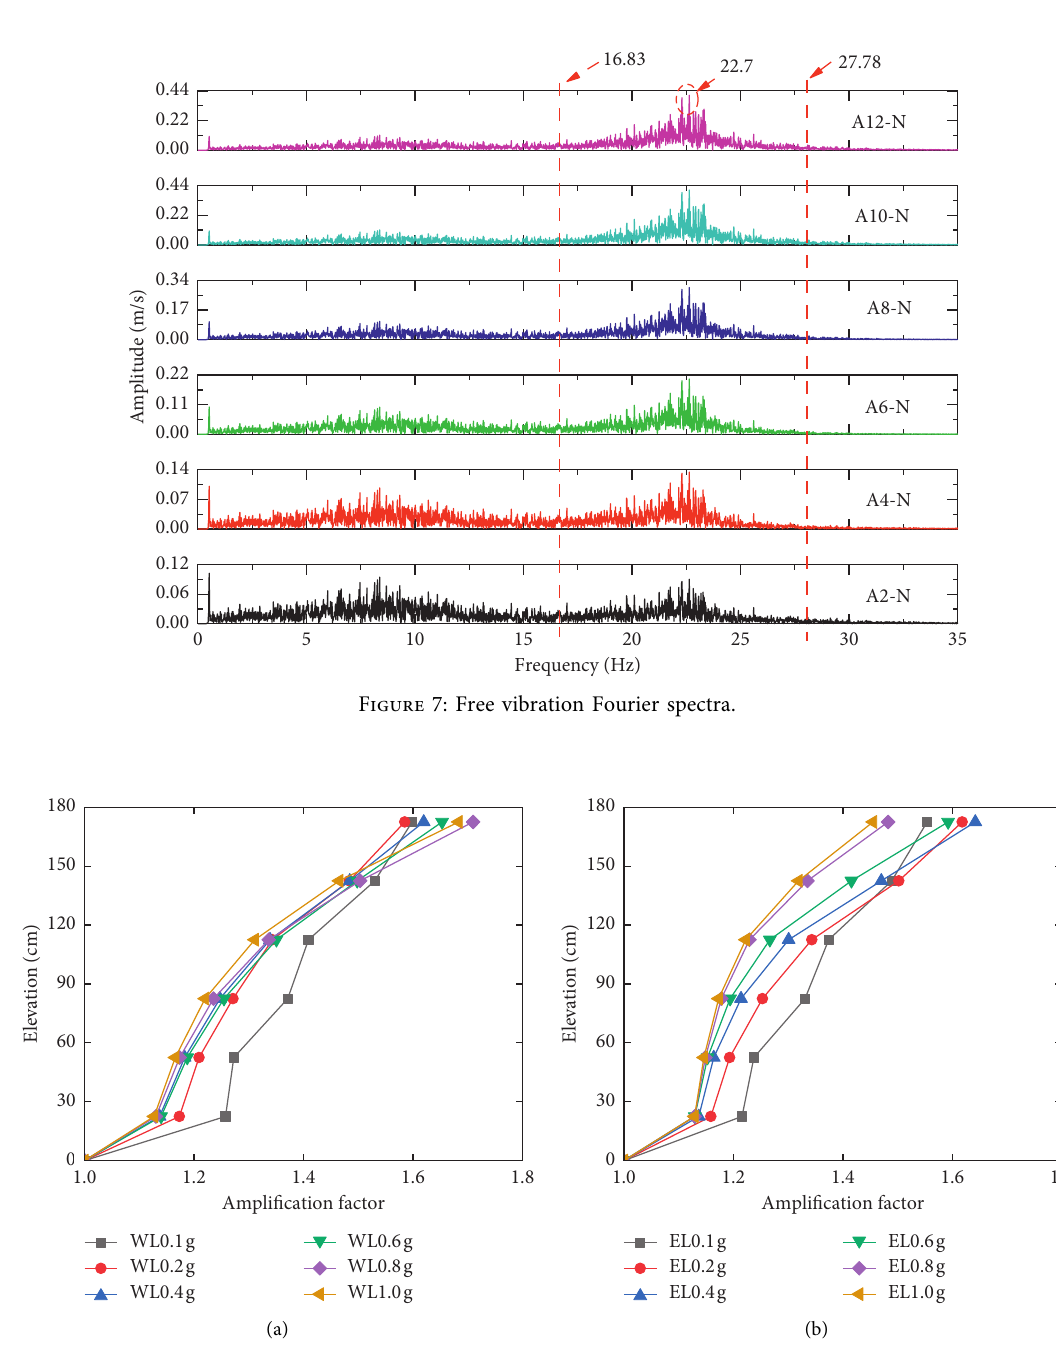
Figure 8: RMS amplification factor for the reinforced zone (scale factor: 1/4): (a) WL and (b)